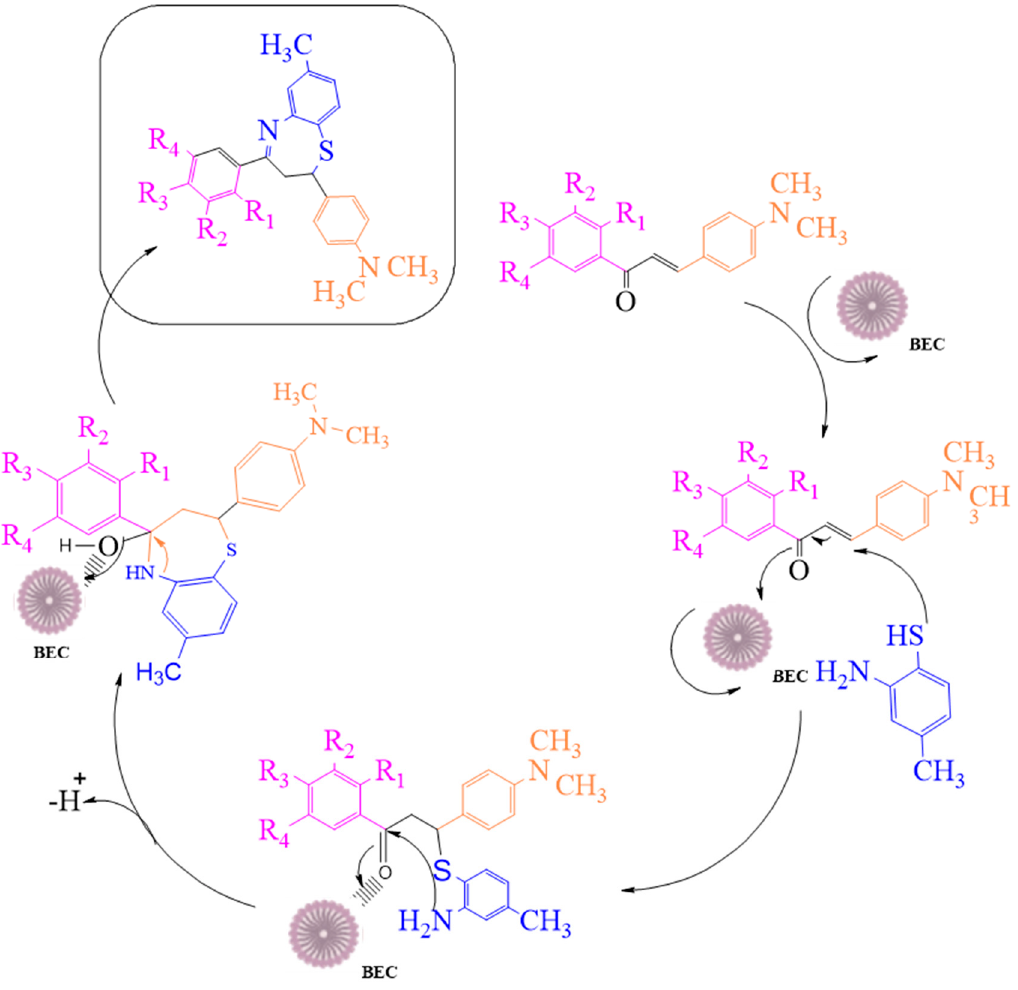
Figure 2. The mechanistic approach for the synthesis of 1,5-benzothiazepine